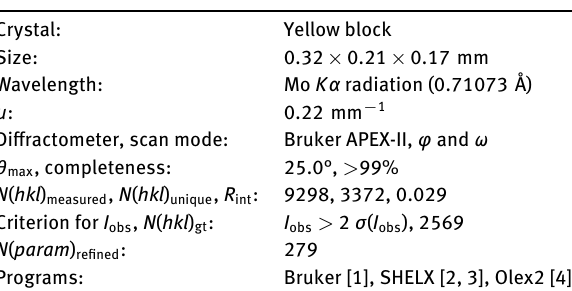
Table 1: Data collection and handling.